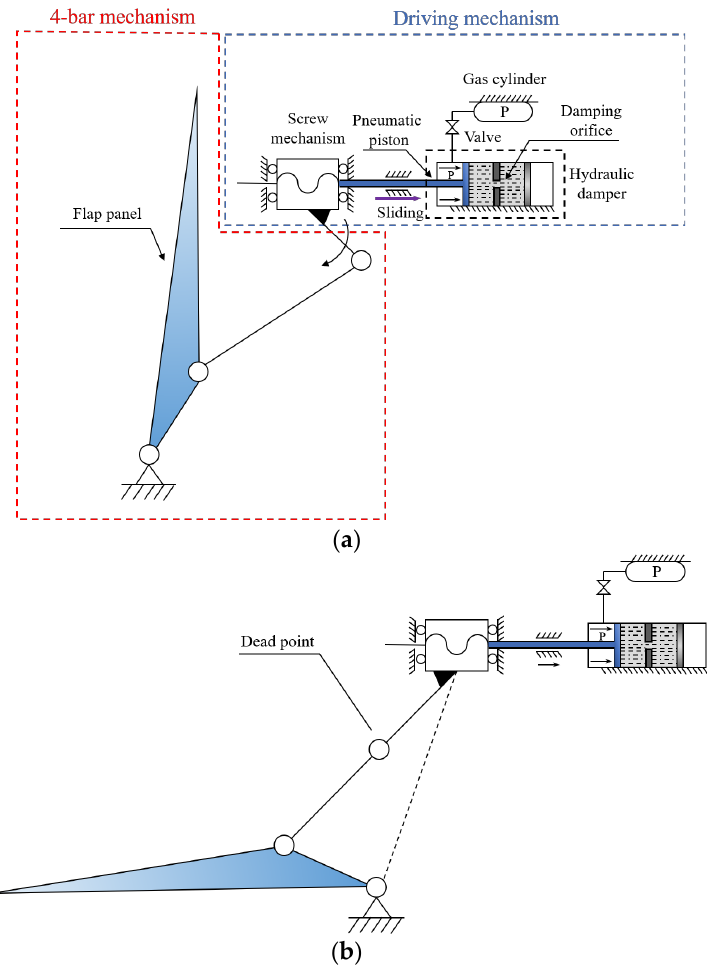
Figure 2. The schematic diagram of the trim flap system: ( a ) Stowed configuration; ( b ) Fully deployed configuration.